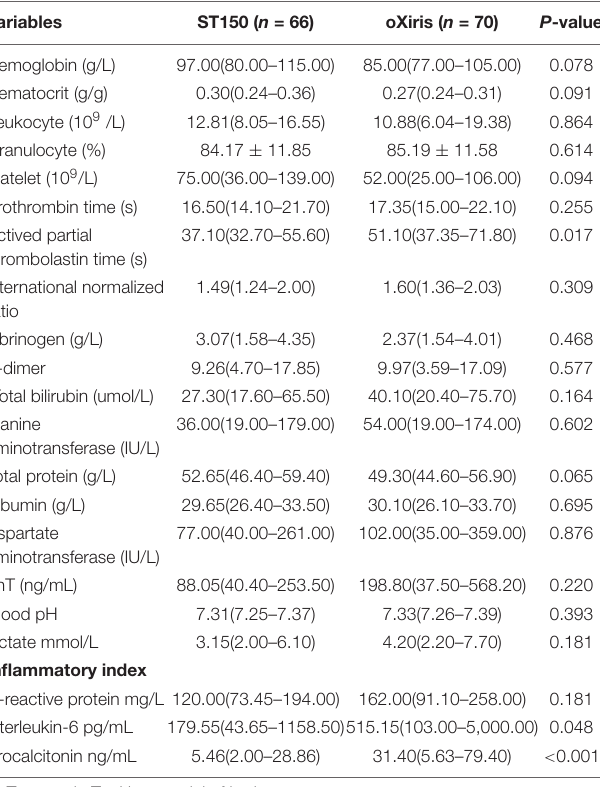
TABLE 1 | The general characteristics. TABLE 2 | The laboratory